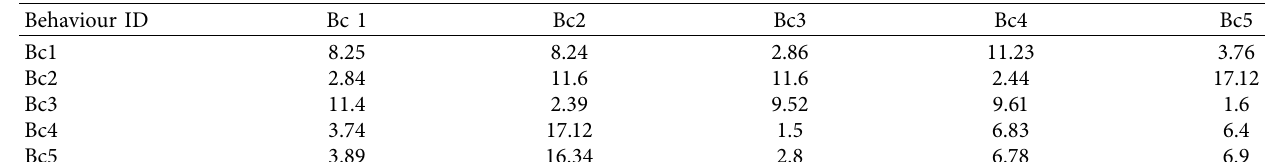
Table 4: Data similarity.